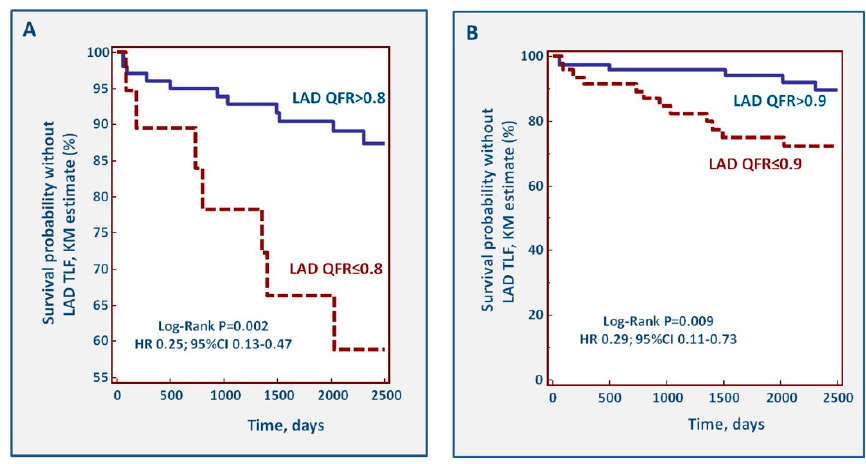
Figure 5. Kaplan–Meier curves for LAD-TLF assuming a cut-off LAD QFR value ≤ 0.80 ( A ) and ≤ 0.90 ( B ).